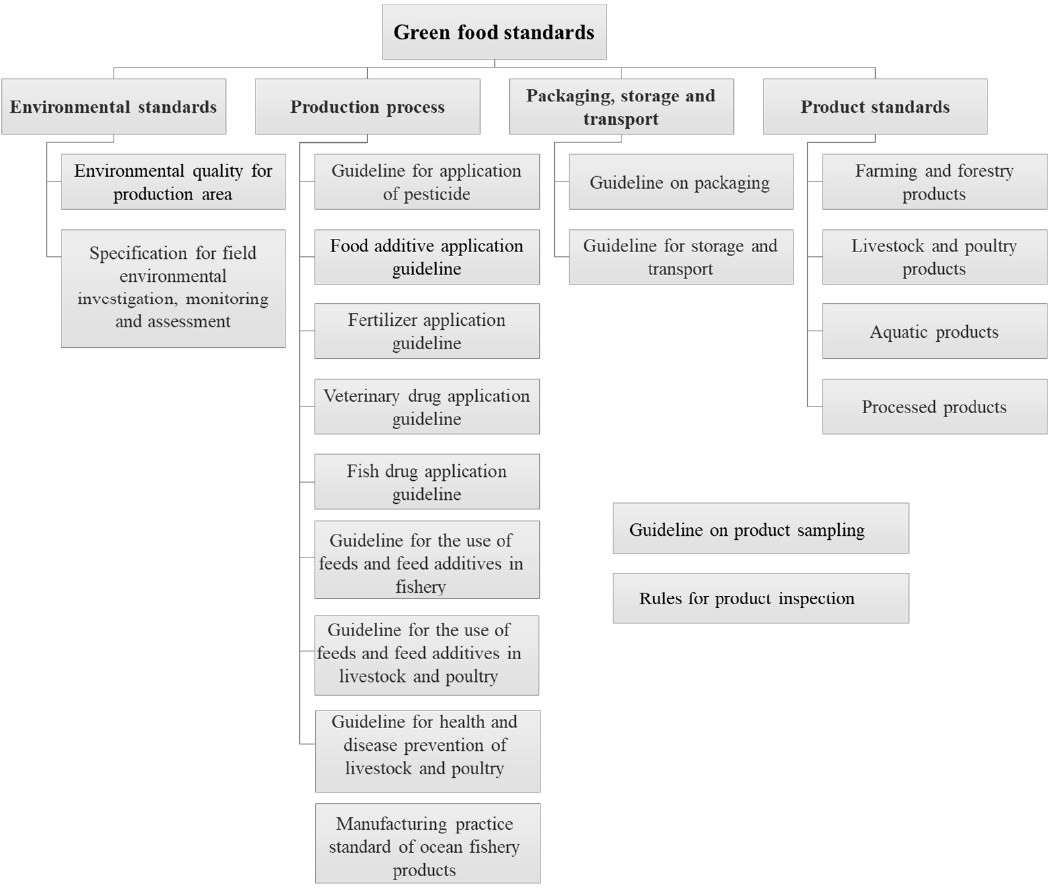
Figure 2. The well-established standard system of green food for food quality control in China.